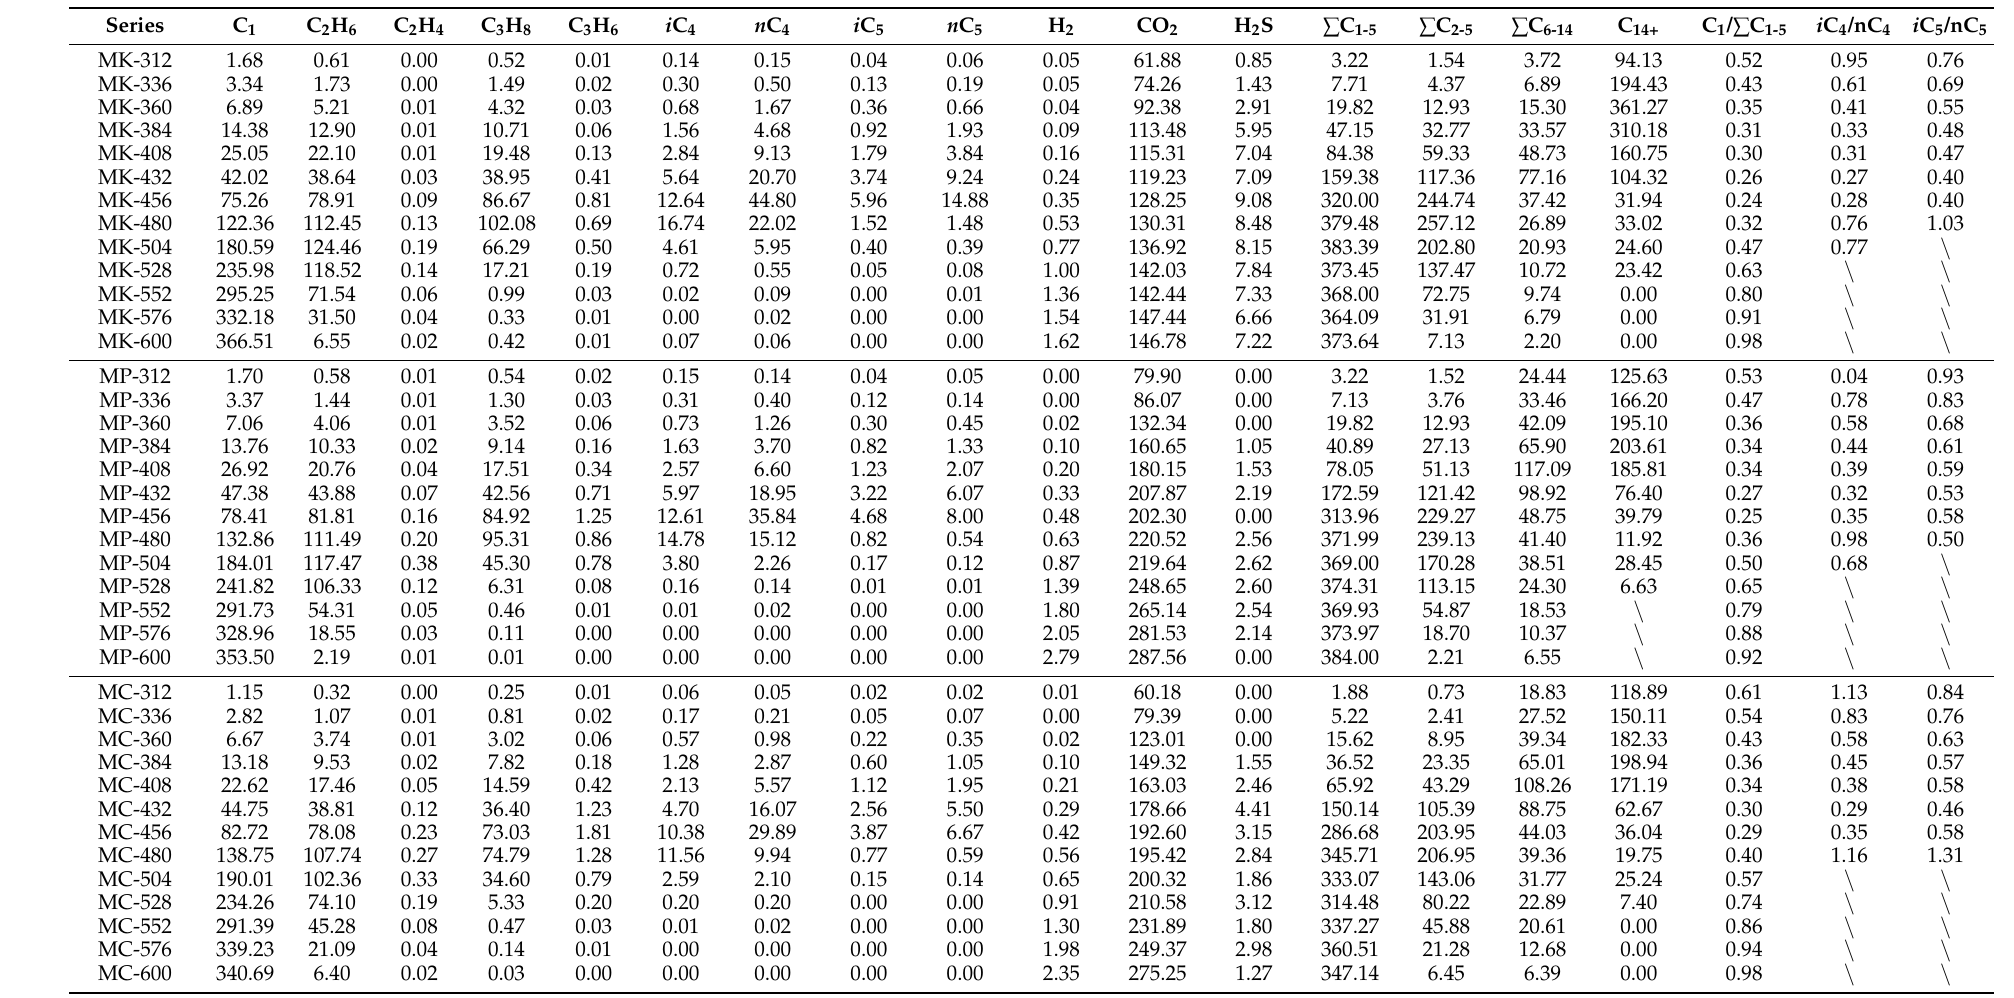
Table 2. Yields of gaseous, liquid hydrocarbons and inorganic gases generated by pyrolysis of kerogen, powdered rock and core plugs of Maoming oil